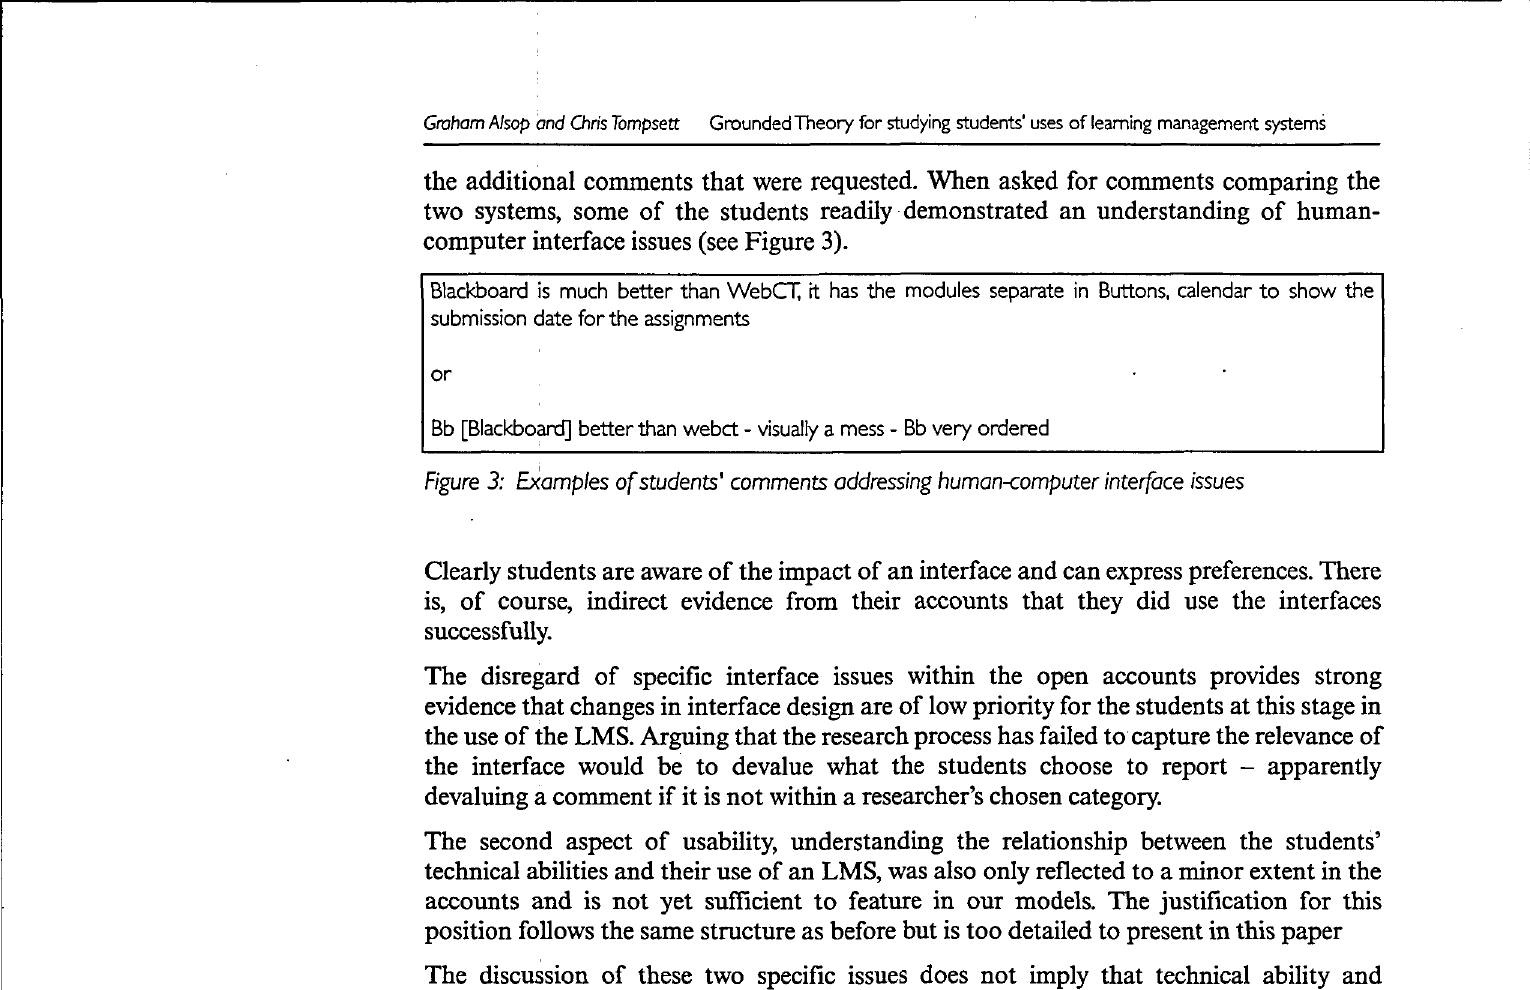
Figure 3: Examples of students' comments addressing human<omputer interface